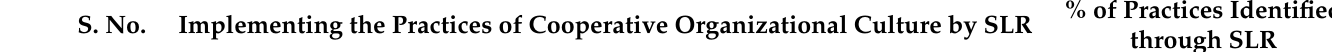
Table 4. Practices for implementing cooperative organizational